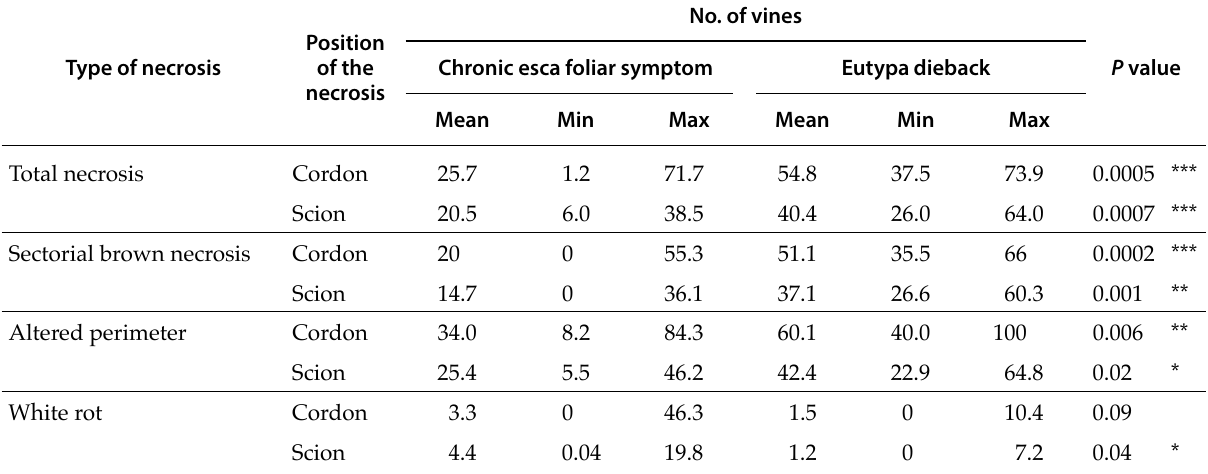
Table 4. Percentage of the total cross-sectional area of wood corresponding to each type of necrosis, in the cordon alone and in the whole scion of the vine expressing chronic esca foliar symptoms or Eutypa dieback symptoms. Values are means, Minimum and Maximum values of 10 vines with P values (Wilcoxon test , * P <0.01, ** P <0.001, *** P